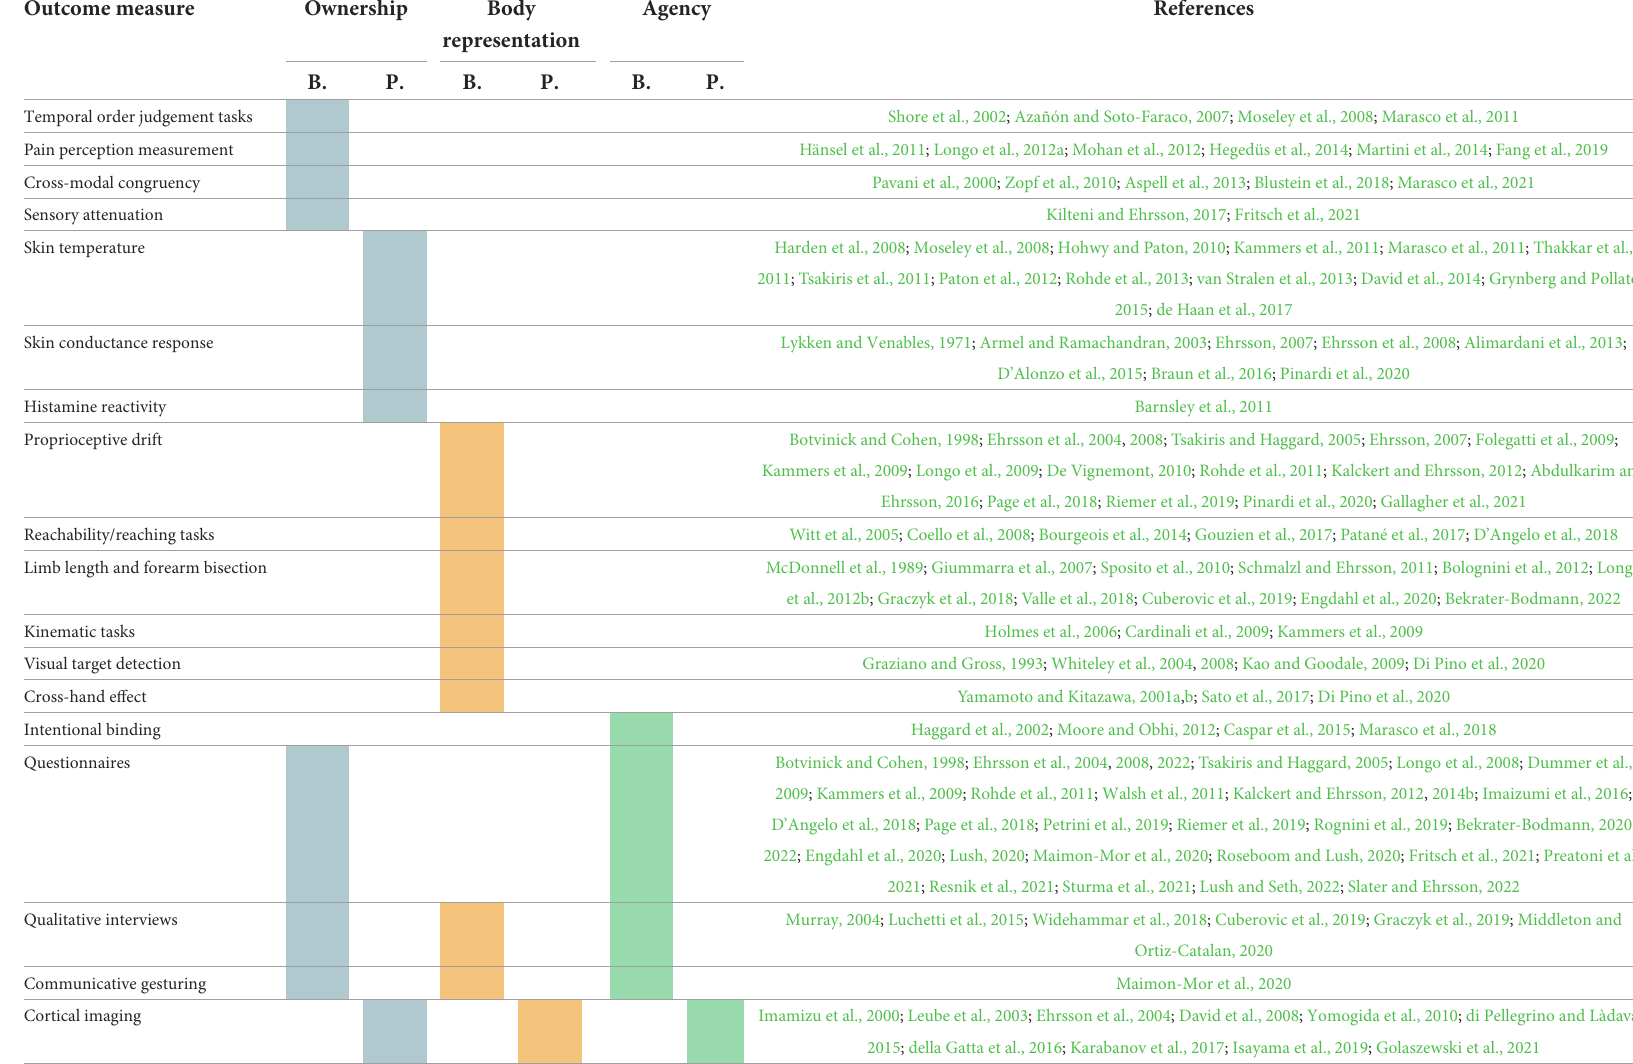
TABLE 1 Existing and emerging behavioral (B.) and physiological (P.) outcome measures for prosthesis embodiment. Outcome